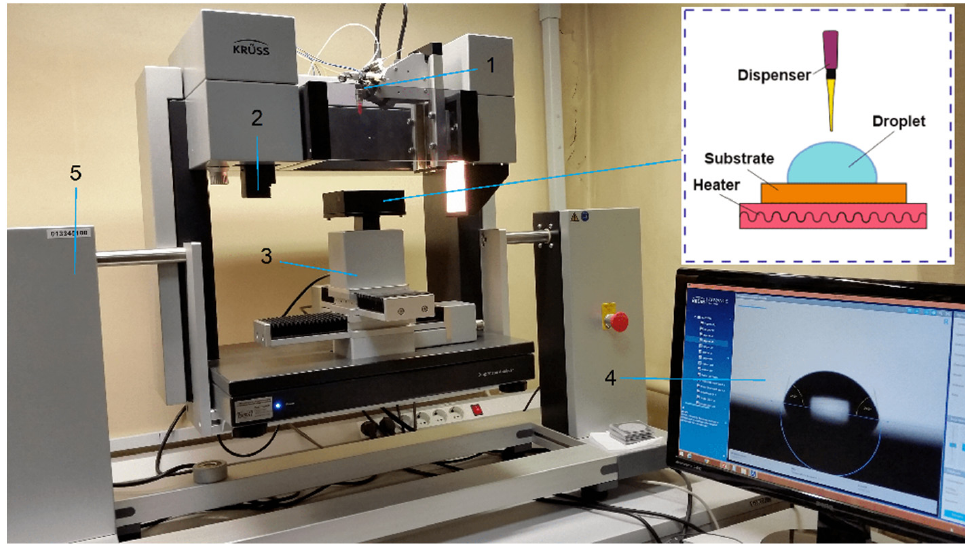
Figure 1. KRÜSS DSA 100 experimental setup: 1—dosing system; 2—camera; 3—three-axis positioning system; 4—processed image of a droplet; 5—automatic inclination system.